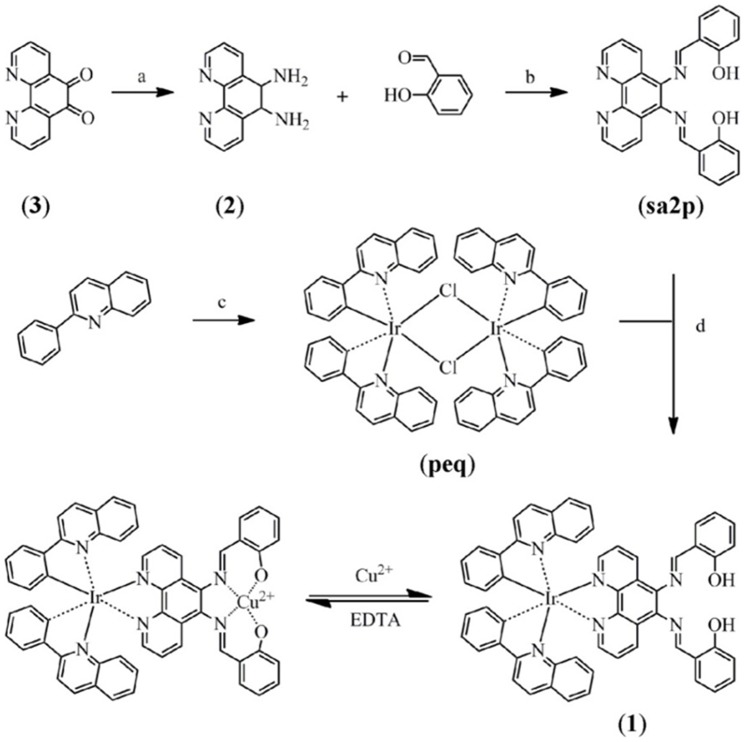
Synthetic pathway of 1.a) NH2OH·HCl, BaCO3, Pd/C, N2H4·H2O, reflux in EtOH; b) reflux in dry MeOH; c) stir in 2-ethoxyethanol at 100°C; (d) reflux in ethylene glycol.